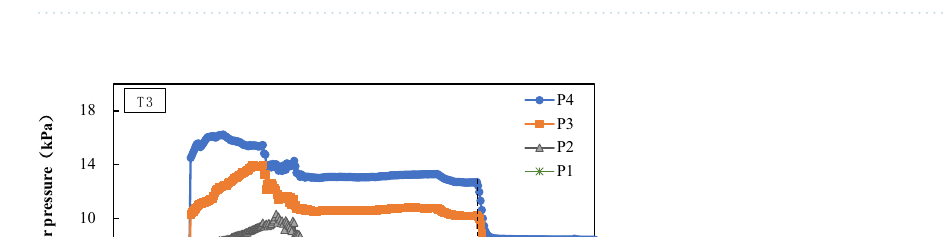
Table 1. Test arrangement.